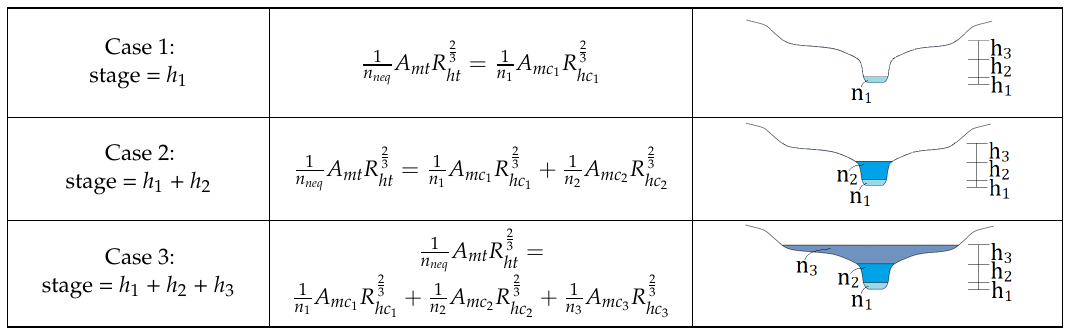
Table 1. Definition of each case.